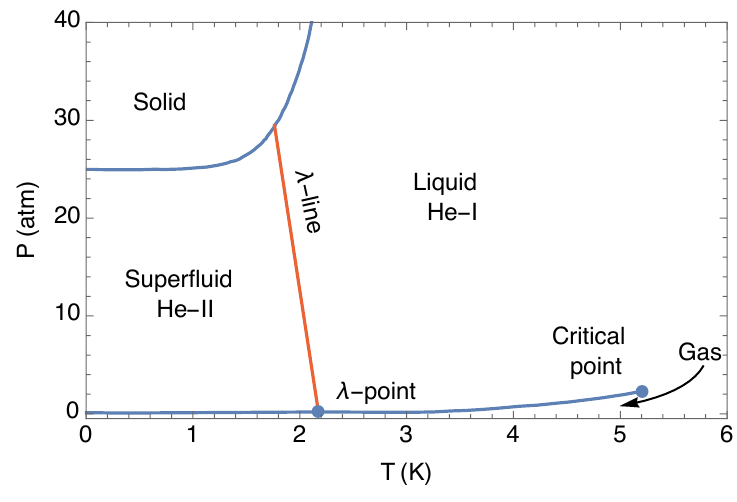
Figure 1 . Schematic representation of the 4 He phase diagram. Figure taken from